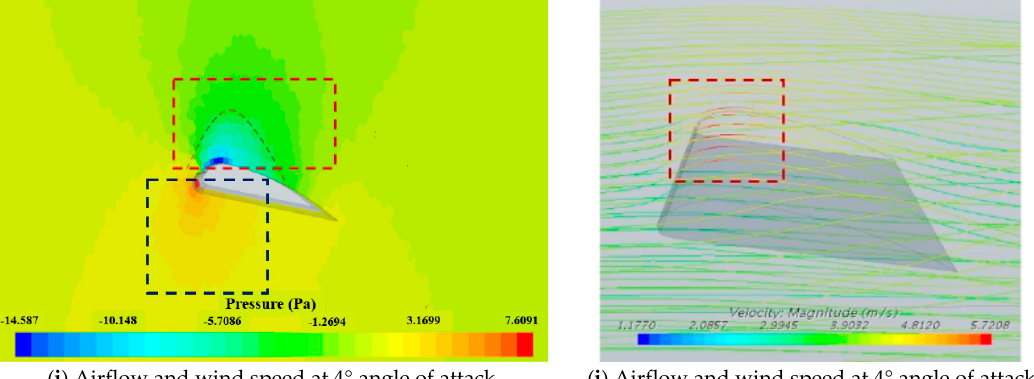
Figure 15. Analysis of the pressure distribution for di ff erent angles. Energies 2020 , 13 , x FOR PEER REVIEW